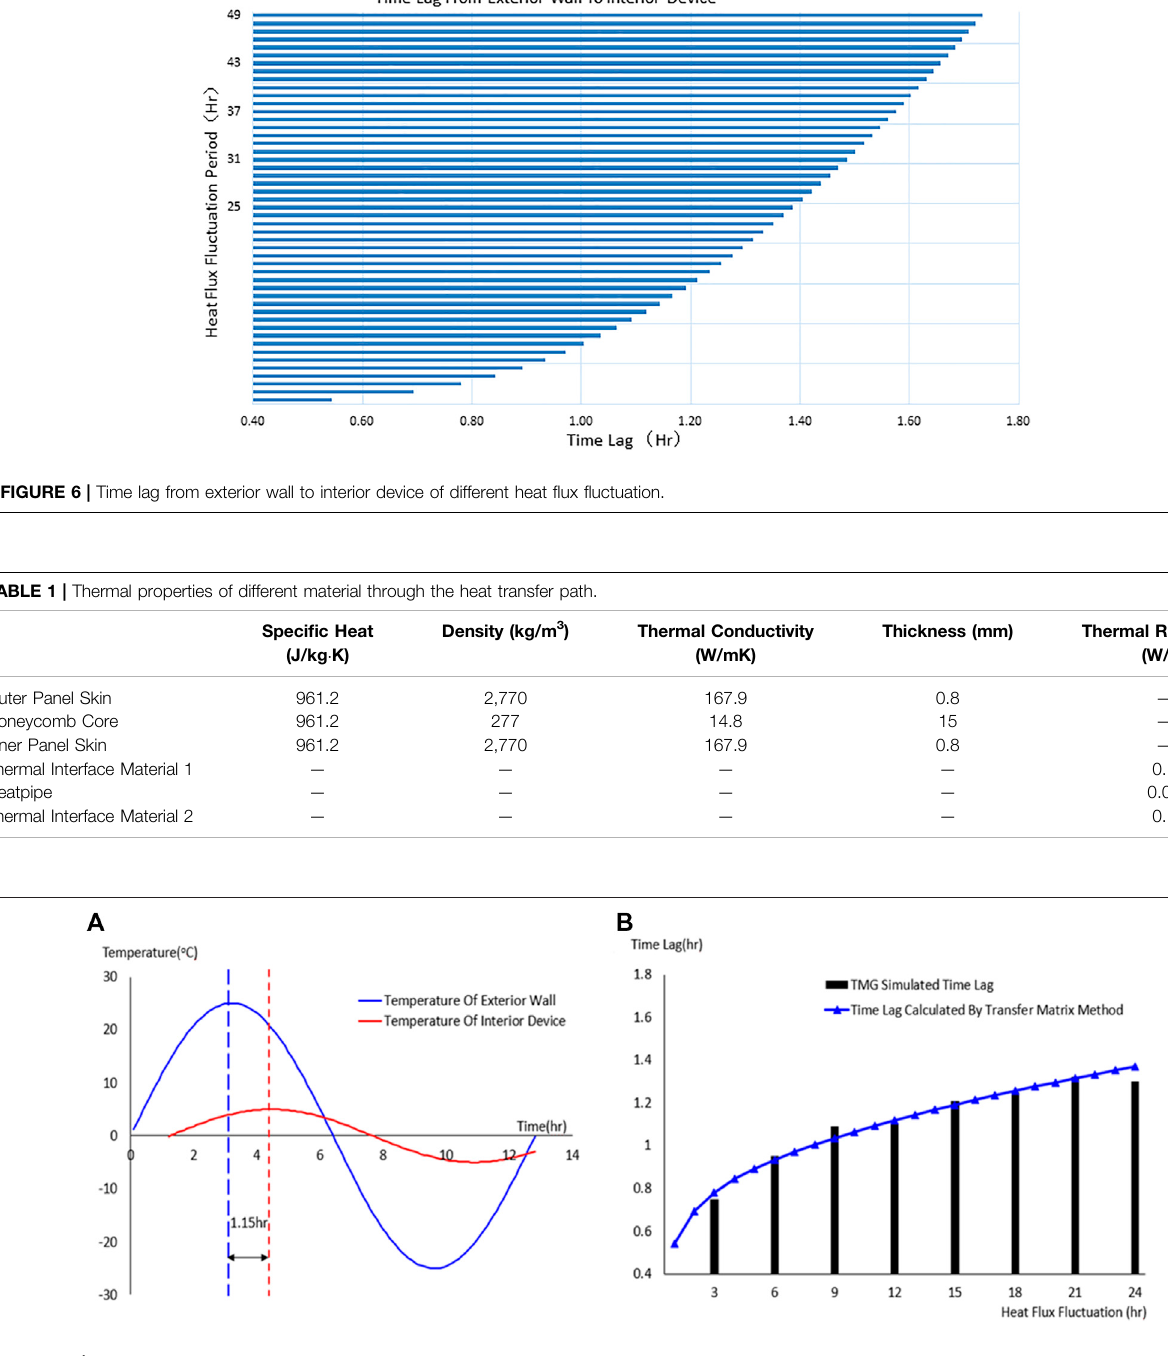
FIGURE7| TimelagcomparisonbetweentransferfunctionmethodandTMGsimulation. (A) Timelagfor fl uctuationswithaperiodof12.8 hrs. (B) Timelagcaused by fl uctuations at different cycles.